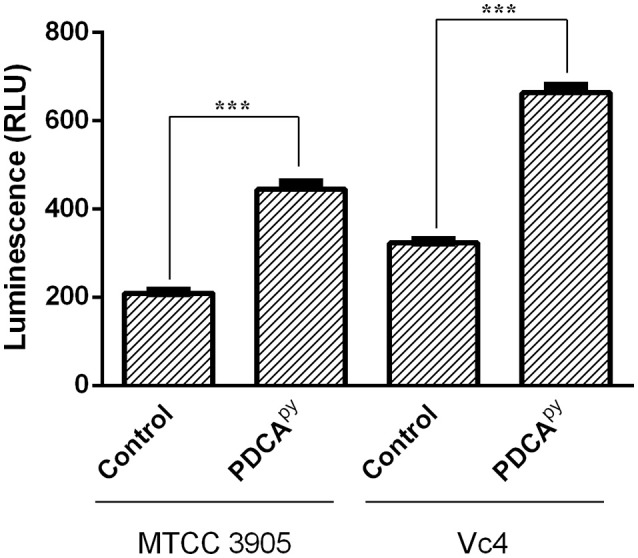
Quorum sensing modulatory effect of PDCApy using cAMP-Glo assay. PDCApy treated samples showed relatively increased luminescence when compared to the untreated samples (control) in both the V. cholerae strains, MTCC3905 (reference strain), and Vc4 (clinical isolate).This implies low cAMP levels as it is inversely proportional to luminescence. ***Indicates significantly different (p ≤ 0.001) compared to untreated control.